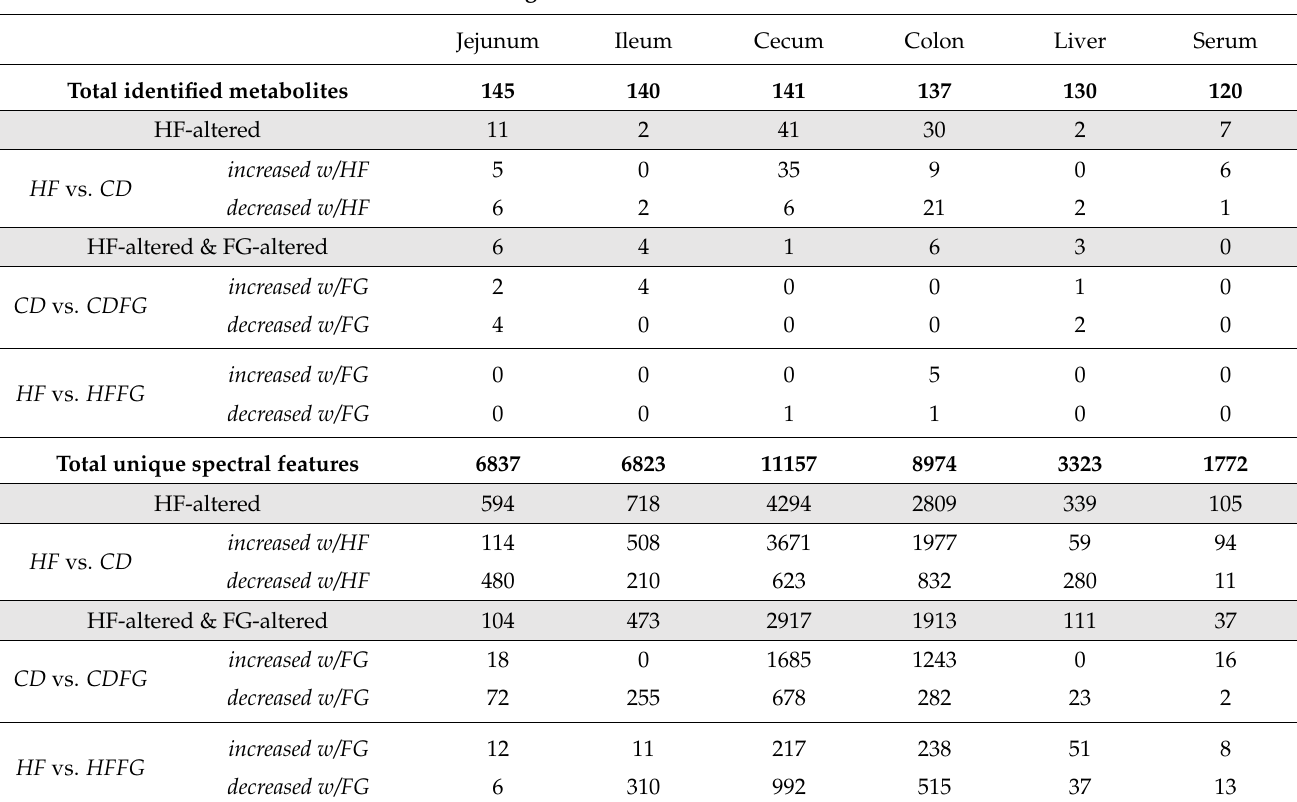
Summary of identified metabolites and unidentified mass spectral features from metabolomics data. Only features with p -values less than 0.05 and fold change greater than 1.5 or less than 0.667 were counted as significantly increased with fenugreek. Features with p -value less than 0.05 and fold change (HFFG/HF) less than 0.667 were counted as significantly decreased with fenugreek.